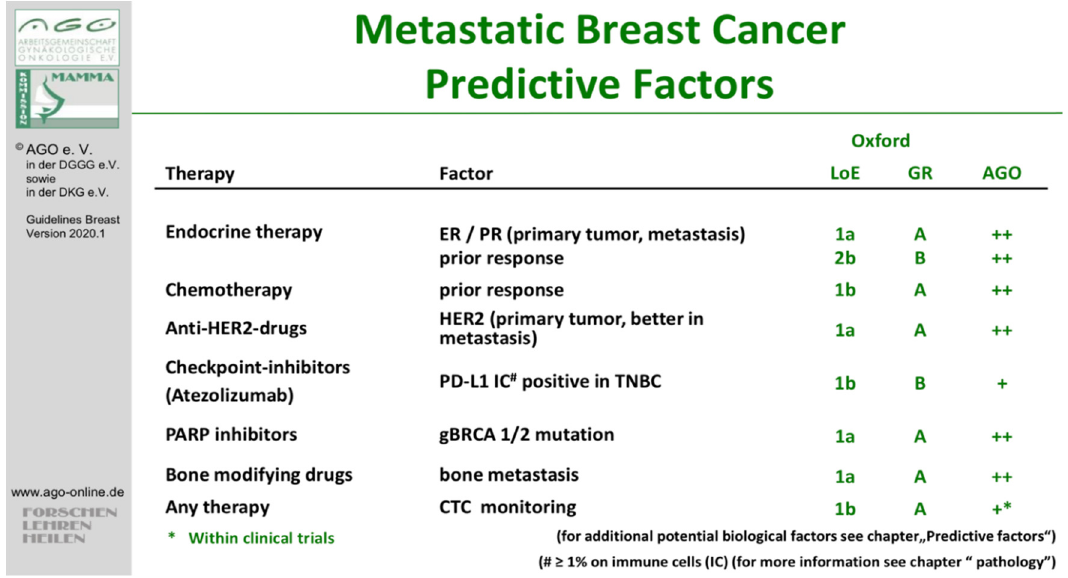
Figure 1. Predictive factors in metastatic breast cancer (mBC), German Gynecological Oncology Group (http://www.ago- online.de) Assessed on 21 Feb 2021. (ER = estrogen receptor, PR = progesterone receptor, HER2 = human epidermal growth factor, PD-L1 = programmed death-ligand 1, TNBC = triple-negative breast cancer, PARP = poly (ADP-ribose) polymerase, gBRCA = germline BRCA, CTC = circulating tumor cell, LoE = levels of evidence, GR = grade, AGO = Arbeitsgemeinschaft Gynäkologische Onkologie (German Gynecological Oncology Group).